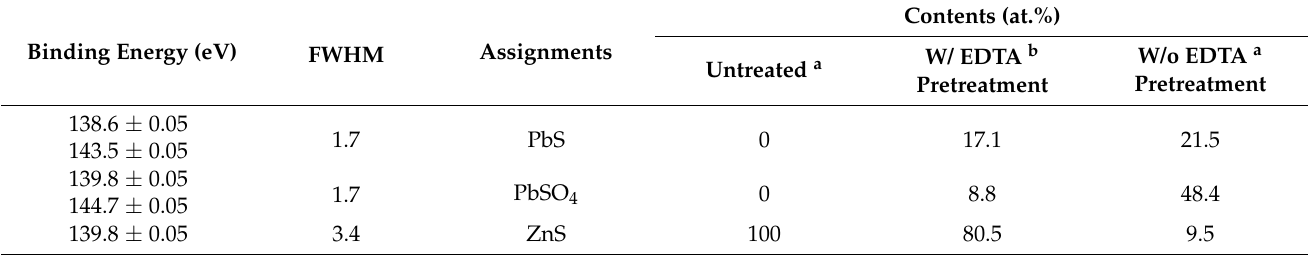
Table 3. XPS peak parameters for Pb4f 7/2 spectra and relative abundances of Pb species.